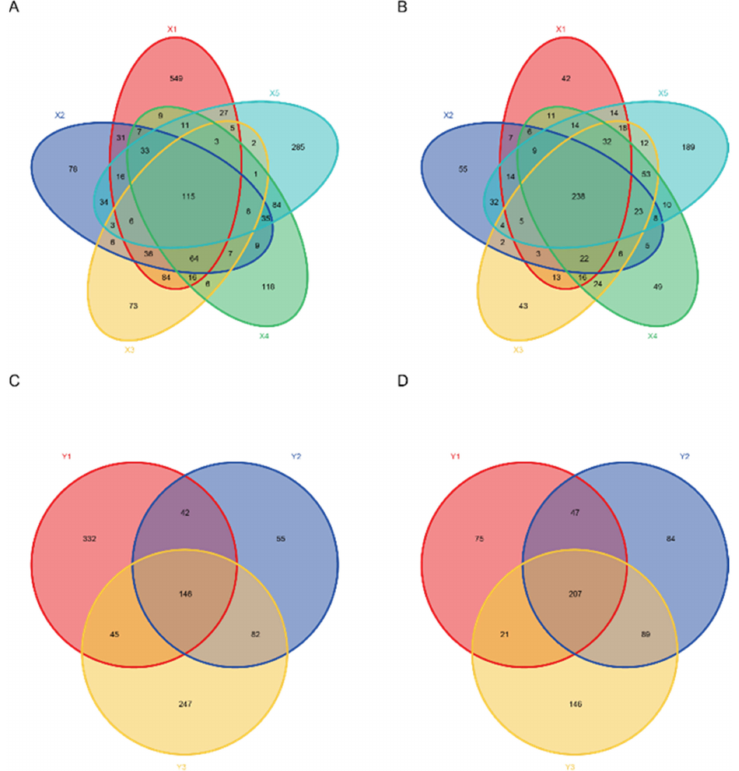
Figure 2. Venn diagrams showing the distribution of unique and shared OTUs within various sample types. ( A ) Sediment sample and ( B ) water sample in stream X; ( C ) sediment sample and ( D ) water sample in stream Y. ( A ) 1012, 486, 433, 524 and 666 OTUs were owned by each sediment sample in stream X while 549, 78, 73, 118 and 285 OTUs were unique OTUs and 115 OTUs were shared by 5 samples. ( B ) 464, 439, 514, 526 and 675 OTUs were owned by each water sample in stream X while 42, 55, 43, 49 and 189 OTUs were unique OTUs and 238 OTUs were shared by 5 samples. ( C ) 565, 325 and 520 OTUs were owned by each sediment sample in stream Y while 332, 55 and 247 OTUs were unique OTUs and 146 OTUs were shared by 3 samples. ( D ) 350, 427 and 463 OTUs were owned by each water sample in stream Y while 75, 84 and 146 OTUs were unique OTUs and 207 OTUs were shared by 3